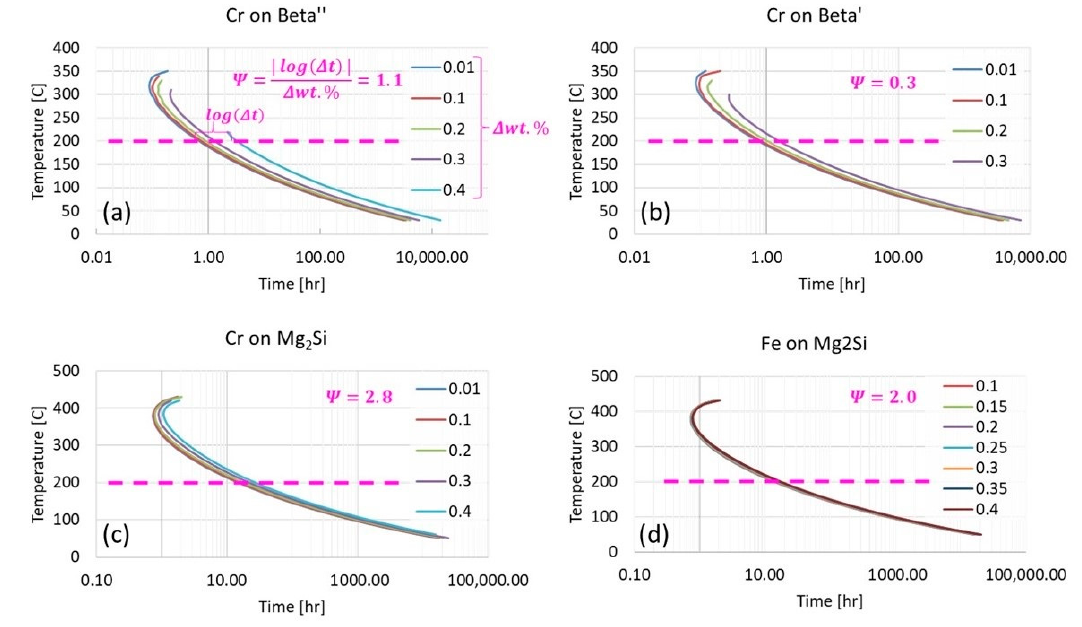
Figure 13. The influence of chromium upon β″ and β′ are presented in ( a , b ), respectively. As for chromium and iron in relation to Mg 2 Si, chromium was found to have a greater ψ at 2.8, as noted in ( c ), versus that of 2.0 for the effect of iron on Mg 2 Si, as shown in ( d ), under the same conditions.